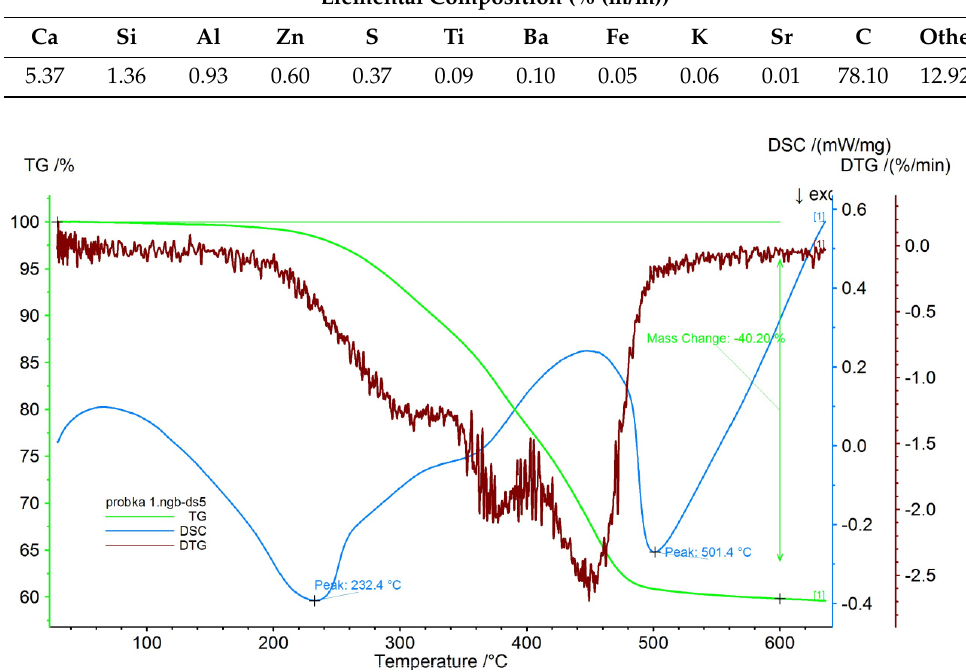
Figure 2. TGA-DTA thermogram of post-consumer thermoplastic elastomer from used car floor mats.